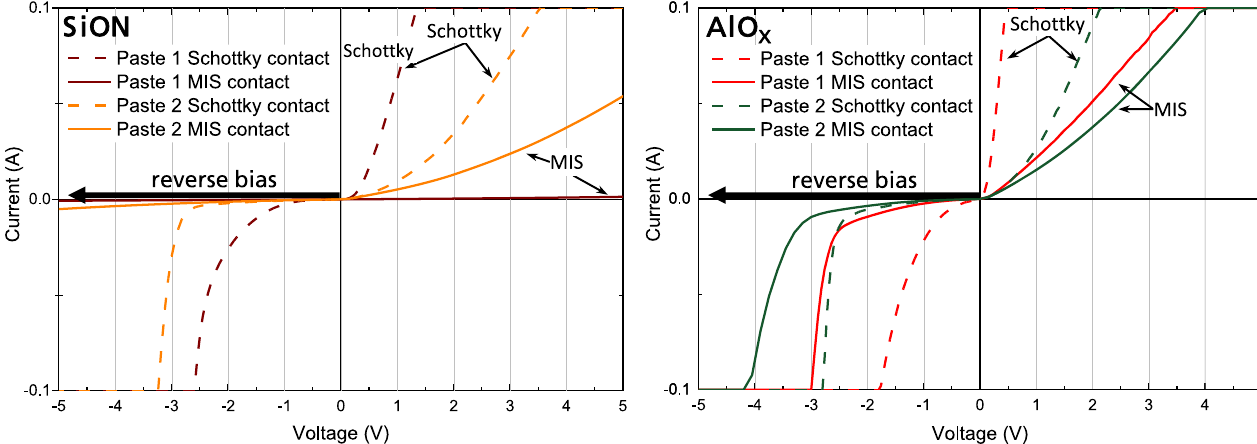
Fig. 4. Current voltage characteristics of quantitative test structures. For each contact one representative IV characteristic is shown. Themeasuredcircularpadshaveaprintedtotalareaof A =3.14mm 2 ,theactualcontactareaofAgandSiisdifferingduetoadditionsinthe screen-printpaste.Thede fi nitionofthepolarityiscongruentwiththeregularoperationofasolarcellfor V > 0(forwardbias)the p -contact is connected to the positive terminal of the measurement device. Therefore, in the 1st quadrant the non-ideal ohmic behavior of the electricalcontactunderforwardbiasisshown.Whileinthe3rdquadranttherectifyingcontactbehaviorofthediodeunderreversebiascan be seen.